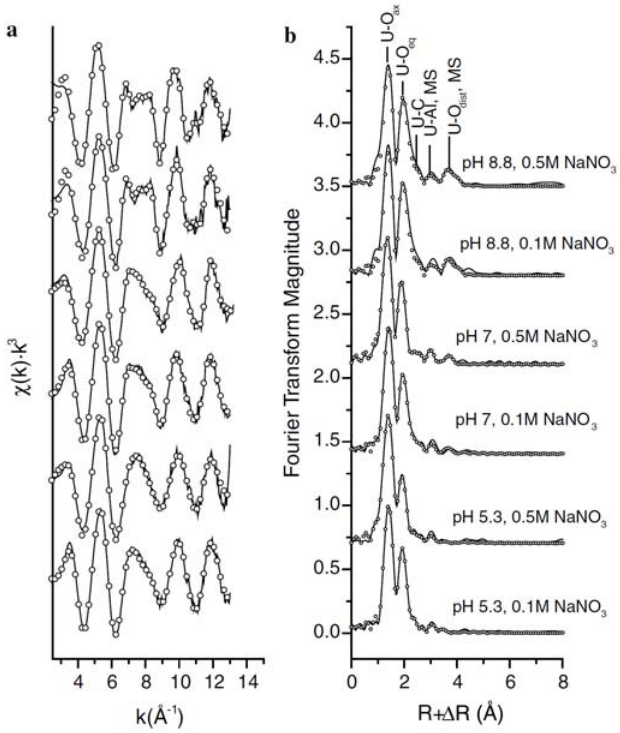
Figure 13. (a) Normalized, background-subtracted k 3 -weighted U L of U(VI) adsorbed imogolite samples. (b) Fourier transformed k 3 -weighted U L EXAFS spectra of U(VI) adsorbed imogolite